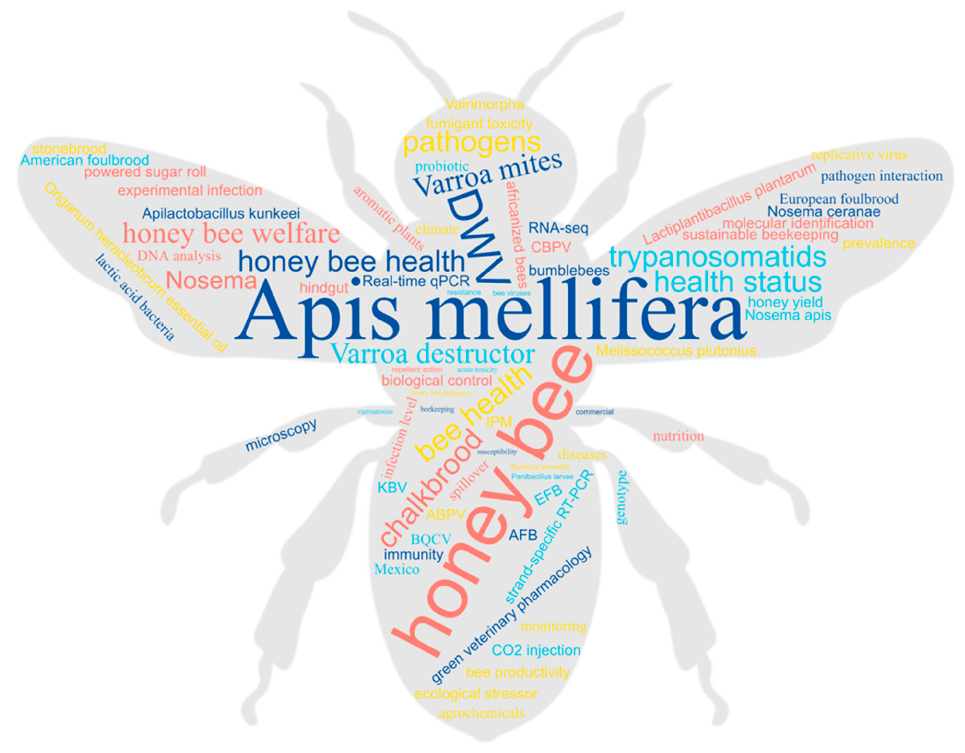
Figure 1. Word cloud generated using the keywords featured in each of the articles included in the Special Issue, with the size of each word corresponding to its frequency of appearance throughout the publications.